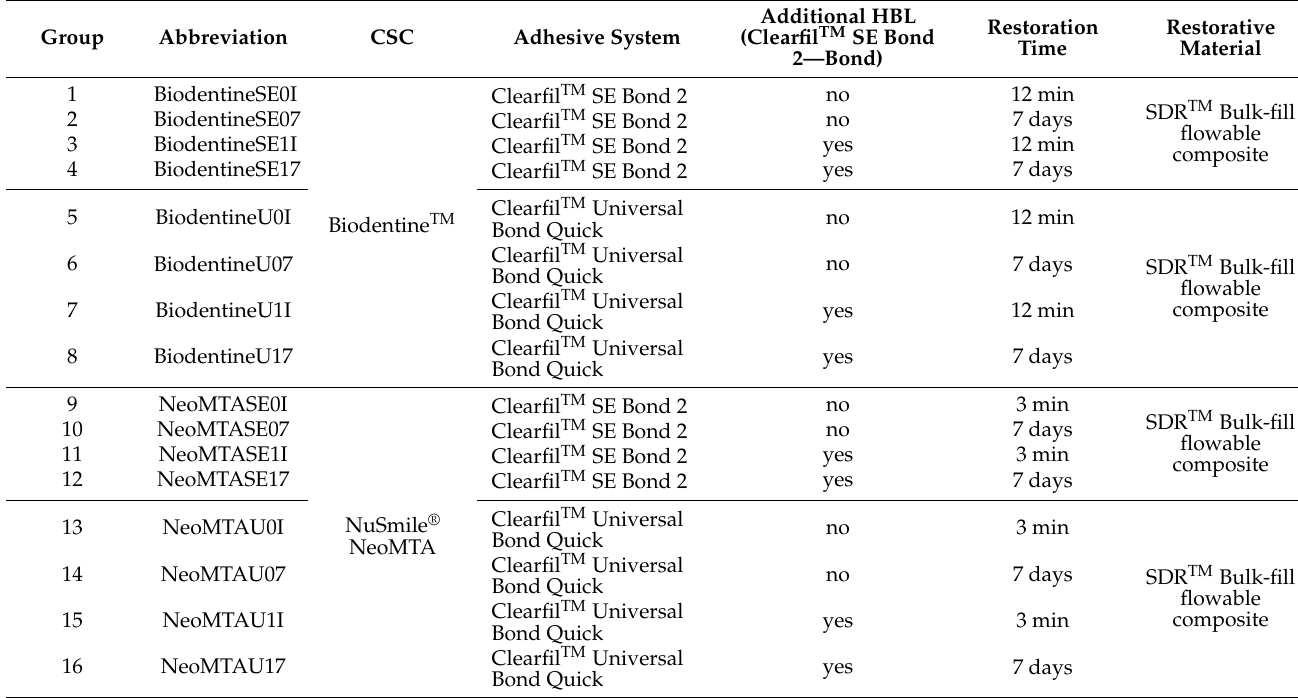
Table 1. Experimental group details: CSC material, adhesive system, additional hydrophobic bonding layer application and time of adhesive/restorative